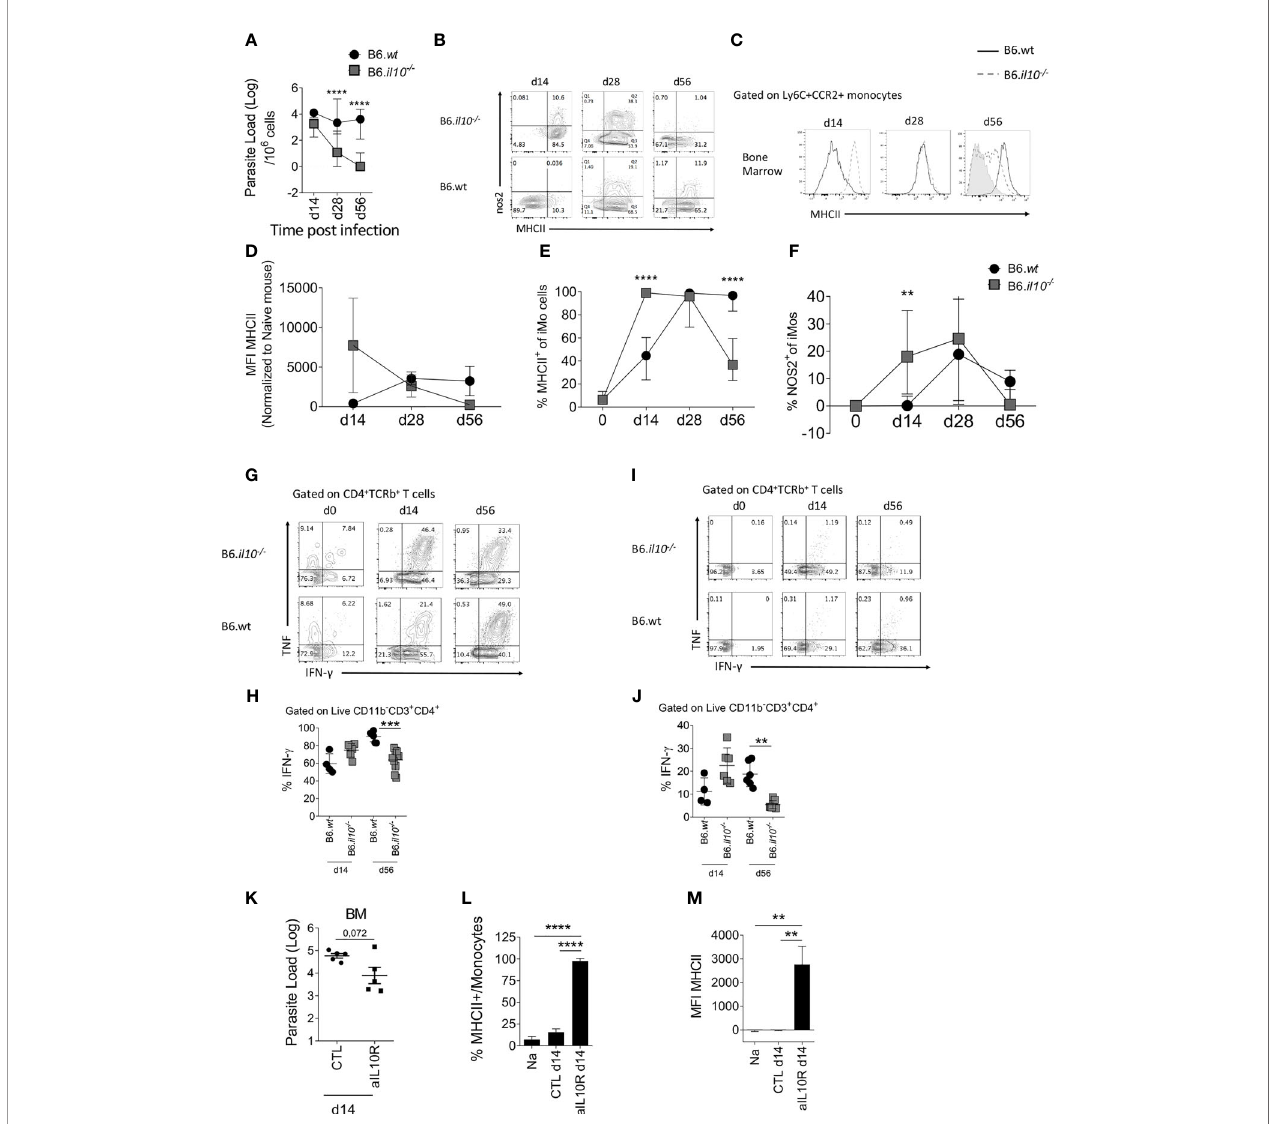
FIGURE 4 | Absence of IL-10 changes the kinetics of monocyte activation in the BM. B6 and B6. Il10 -/- mice were infected with L.donovani amastioges in the tail vein for 14, 28 and 56 days. Data from the BM are shown (A – G) . (A) Parasites burden in the bone marrow determined by limiting dilution assay at the indicated time point. Two- way ANOVA applied on log10 transformed data: P<0.0001; statistical power: 11.9%%; n ≥ 6; post hoc test S ̌ ı ́ da ́ k ’ s MCT: statistical difference reached at day 28 and day 56 (P<0.0001; ****). (B) Dot plot representative of nos2 and MHCII expression by Ly6C + CCR2 + monocytes. (C – F) Histogram (C) , bar graph showing MFI (D) , percentage of MHCII (E) and percentage of nos2 (F) on BM Ly6C + CCR2 + monocytes. Two-way factorial analysis applied in (E) : P=0.001; statistical power: 8.2%; n ≥ 3; post hoc test EMM: statistical difference reached at day 14 and day 56 (P<0.0001; ****); and two-way factorial analysis applied in (F) : P=0.013; statistical power: 6.1%; n ≥ 4; post hoc test EMM: statistical difference reached at day 14 (P<0.0077; **). (G, I) Production of IFN- g and TNF by CD4 + T cells in the BM at the different time point post-infection and (H, J) percentage of IFN- g produced by CD4 + T cells after PMA-Ionomycin-BFA stimulation for 4h (G, H) and ex vivo (BFA stimulation only, (I, J) . Brown-Forsythe ANOVA applied in (H) : P<0.0001; statistical power: 43.8%; n ≥ 4; post hoc test Dunnett ’ s T3: statistical difference reached at day 56 (P=0.0003; ***); 95% CI: 8.16 – 30.46; and Brown-Forsythe ANOVA applied in (J) : P=0.0002; statistical power: 47.5%; n ≥ 4; post hoc test Dunnett ’ s T3: statistical difference reached at day 56 (P=0.0032; **); 95% CI: 4.99 – 24.47. (K – M) B6 mice infected with L. donovani were injected with an anti-IL-10 depleting antibody or the isotype control for 14 days starting 1 day prior to the infection (K) Parasite load determined by limiting dilution assay in the BM at day 14 p.i. Welch ’ s t test applied: P=0.0717; 95% CI: -1.86 – 0.115; statistical power: 13.9%; n =5. (L) Percentage and (M) MFI of MHCII expressed on Ly6C + CCR2 + monocytes. Brown-Forsythe ANOVA applied in (L) : P<0.0001; statistical power: 100%; n ≥ 3; post hoc test Dunnett ’ s T3: statistical difference reached in NA vs . aIL10R (P<0.0001;****; 95% CI: -79.79 – -53.75) and CLT vs . aIL10R (P<0.0001; ****; 95% CI: -67.77 – -49.41); and Brown-Forsythe ANOVA applied in (M) : P=0.0009; statistical power: 100%; n ≥ 3; post hoc test Dunnett ’ s T3: statistical difference reached in NA vs . aIL10R (P<0.0034; **; 95% CI: -4367 – -1169) and CLT vs . aIL10R (P<0.0034; **; 95% CI: -4361 – -1175). For (A – J) , data are derived from analysis of 6 to 7 individual mice (2 to 4/experiment) of each strain at each time point pooled from two independent experiments and are shown as mean ± SD. Data in (B, C, G) and I are representative plots. For (K – M) , data are the pool of 5 mice/group/time point. Mean ± SD is shown. Experiment was performed once. In (A, D – F) median with 95% CI is shown. For (H, J) statistical details are found in Table S1